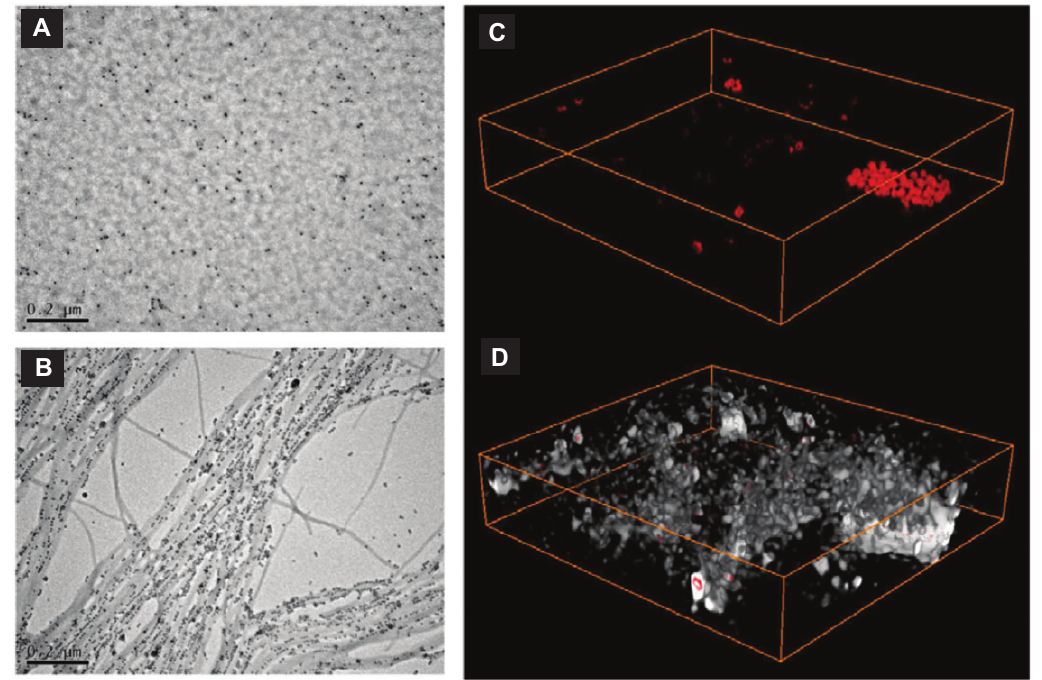
Figure 3 TEM and electron tomography images of investigated materials. (A) TEM image of a non-fibrillated sample of bovine insulin grinded with iron oxide. (B) Corresponding image of the fibrillated material. (C) Electron tomography image of high contrast area (imaged in red), corresponding to nanoparticles. (D) Electron tomography image with a lower contrast threshold, showing protein material in gray. The image in (C) is overlaid, demonstrating that the nanoparticles are residing within the protein material. Reproduced, with permission from Elsevier, from (50)